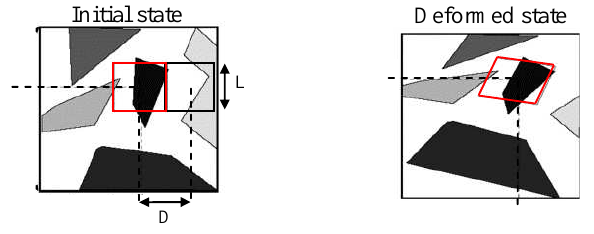
Fig. 3. DIC principle and definition of the (L,D) correlation parameters